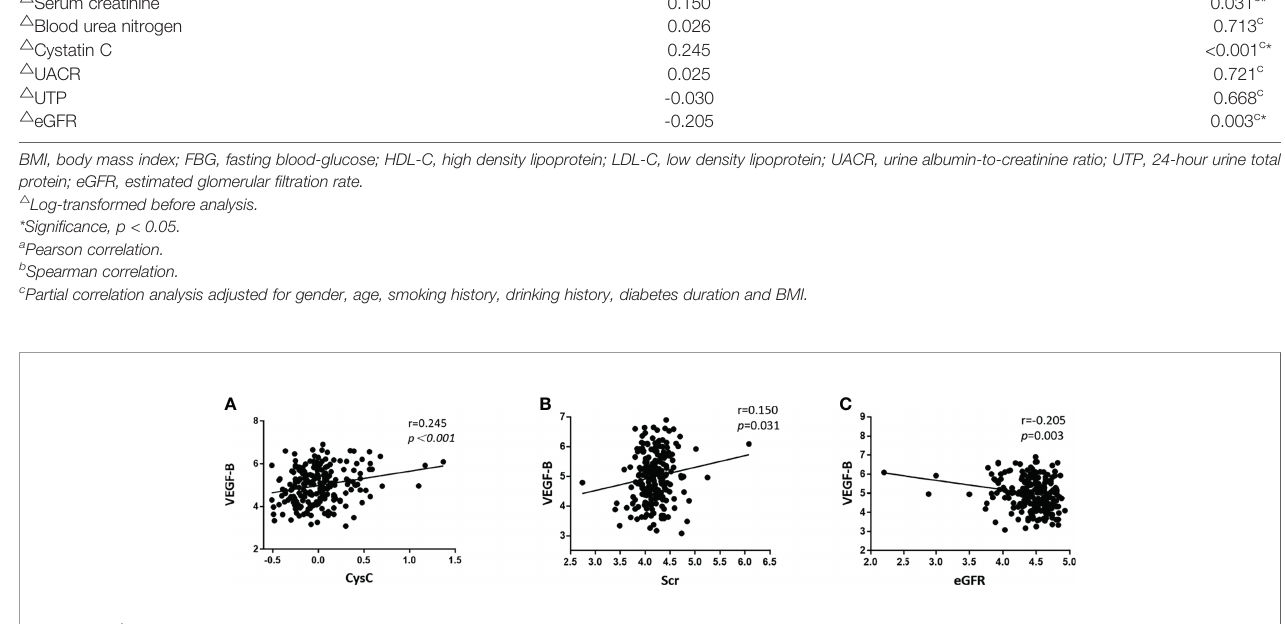
FIGURE 2 | Scatter diagrams showing the signi fi cant partial correlations between serum VEGF-B levels and renal function indicators in T2DM patients after adjusting for gender, age, smoking history, drinking history, diabetes duration and BMI. (A) The serum VEGF-B level was positively correlated with Cystatin C (r=0.245, p < 0.001); (B) The serum VEGF-B level was positively correlated with Scr (r=0.150, p =0.031); (C) The serum VEGF-B level was negatively correlated with eGFR (r=- 0.205, p =0.003). All data was log-transformed before analysis.